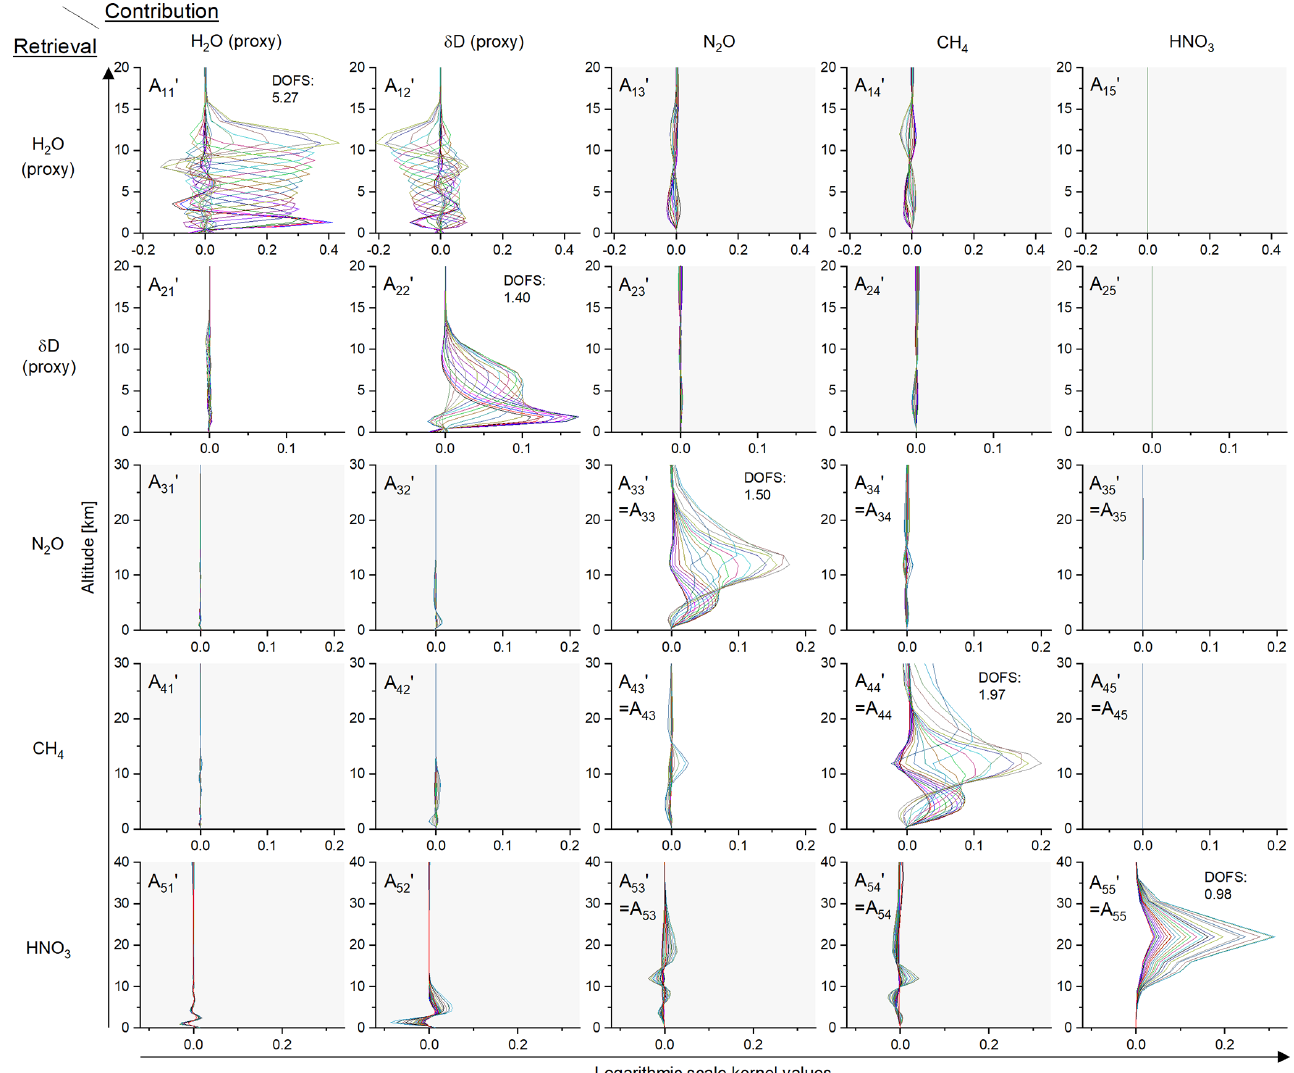
Figure 9. Example of an averaging kernel for the full atmospheric composition state vector that is optimally estimated by the MUSICA IASI retrieval procedure: { 1 (ln [ H 2 O ]+ ln [ HDO ] ) , (ln [ HDO ]− ln [ H 2 O ] ) , ln [ N 2 O ] , ln [ CH 4 ] , ln [ HNO 3 ]} . The kernel is for the 30 August 2008 2 example observation over Lindenberg used for Fig. 4. Please note that 1 (ln [ H 2 O ]+ ln [ HDO ] ) and (ln [ HDO ]− ln [ H 2 O ] ) are good proxies 2 for H 2 O and δ D,